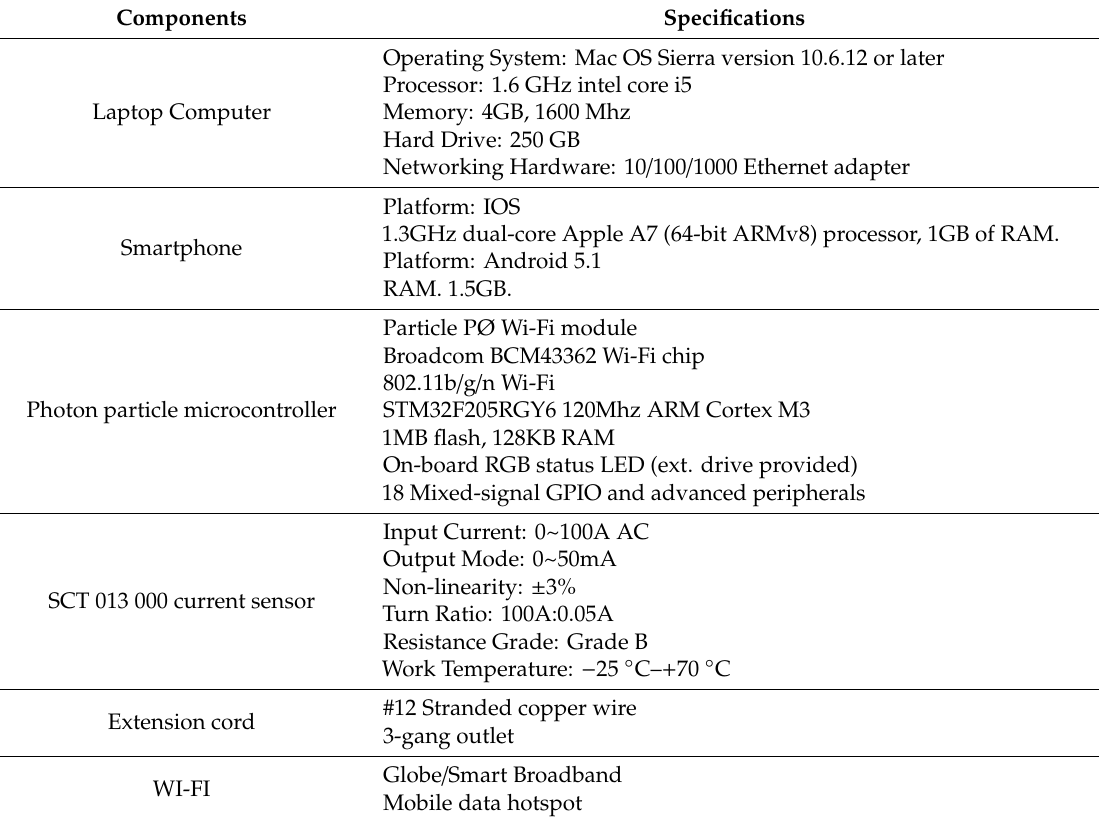
Table 4. The proposed EECMS device’s hardware components and its specifications. Components